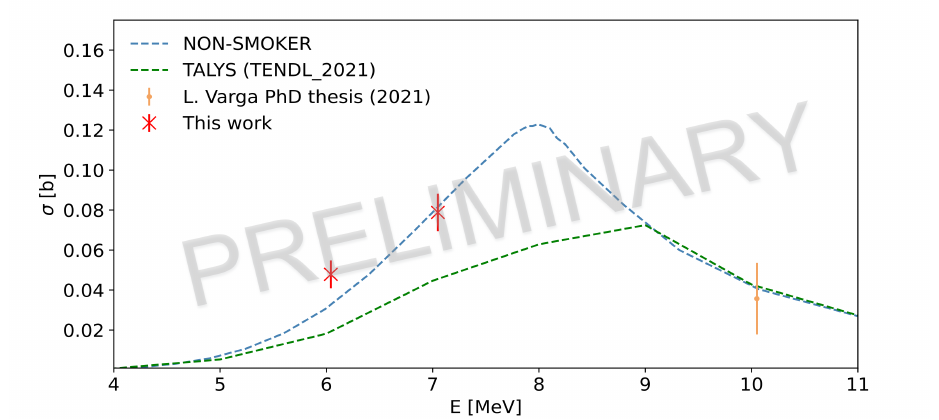
Figure 3. Preliminary cross sections obtained in this work in comparison with theoretical